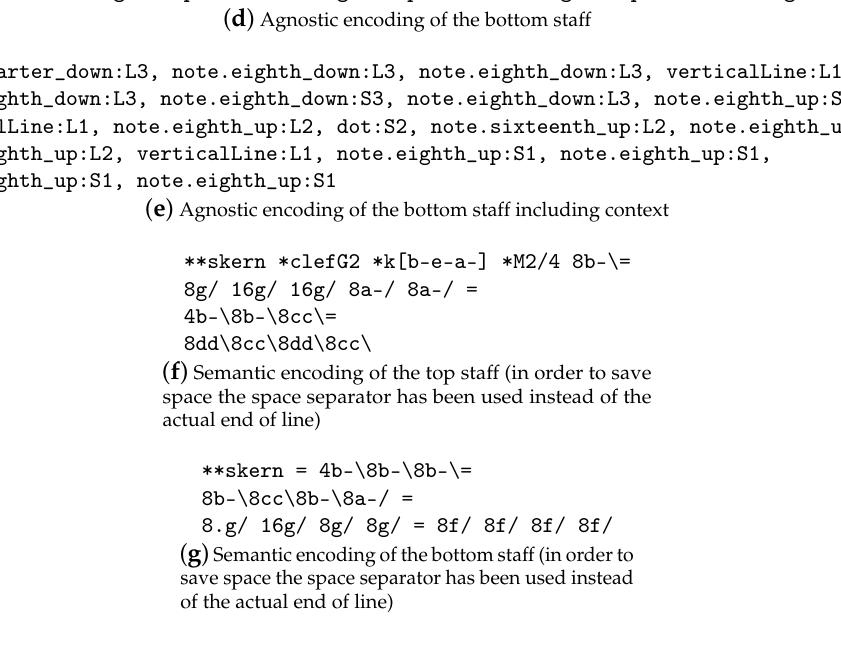
Figure A1. Sample from the FMT corpus ( a ) [37], where we observe both the raw and contextual agnostic encoding of the both staves ( b – e ) and their corresponding **kern ∗ sequence ( f , g